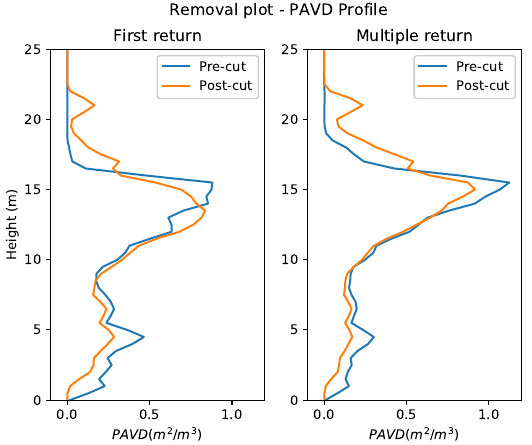
Figure 7. Comparison of the first-return and multiple-return Plant Area Volume Density (PAVD) profiles of the removal